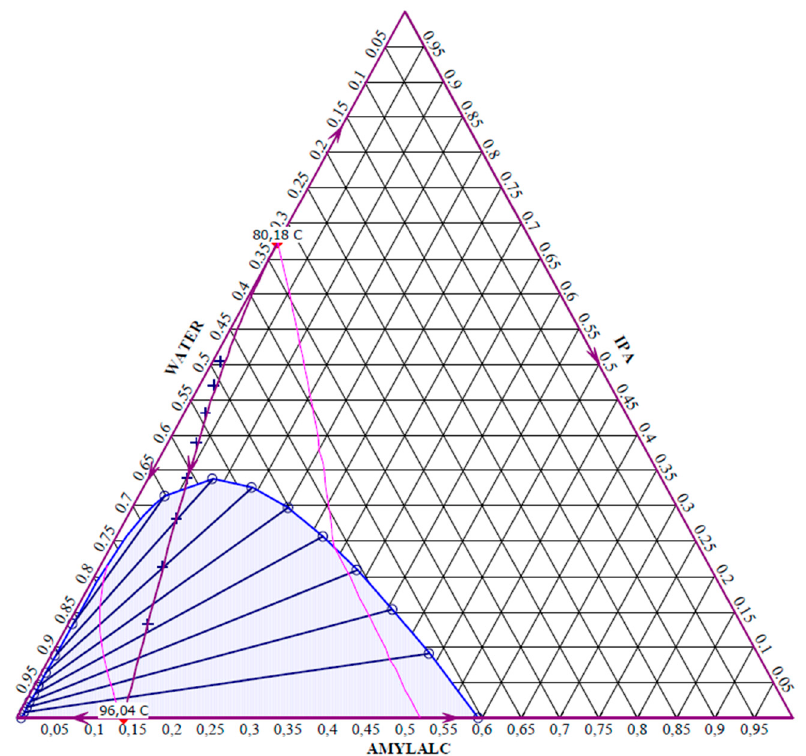
Figure 8. Ternary map at 1 atm, obtained by means of Aspen Plus ® V11 [61] using the NRTL model, for the system 2-propanol (IPA) + water (WATER) + amyl alcohol (AMYLALC).